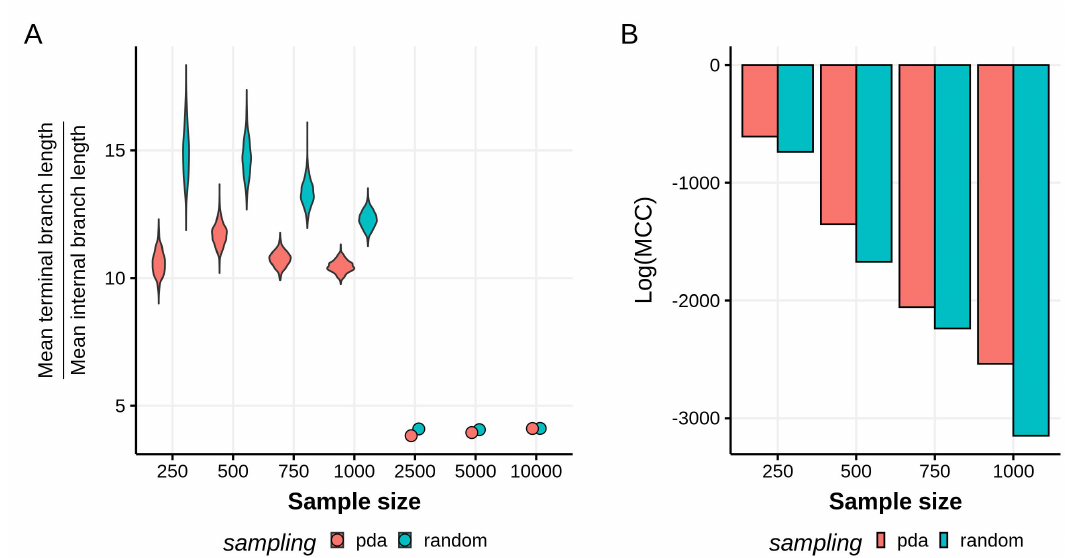
Figure 1. ( A ) Ratios between the mean terminal branch lengths and the mean internal branch lengths. The higher this ratio, the more star-like a phylogeny. Violin plots are shown for sample sizes in which tree distributions are available. ( B ) Log-maximum clade credibility (MCC) scores of each empirical tree distribution. Tree distributions sampled using the Phylogenetic Diversity Analyzer (PDA) method have higher MCC scores, implying somewhat less variance in the tree topologies reconstructed.